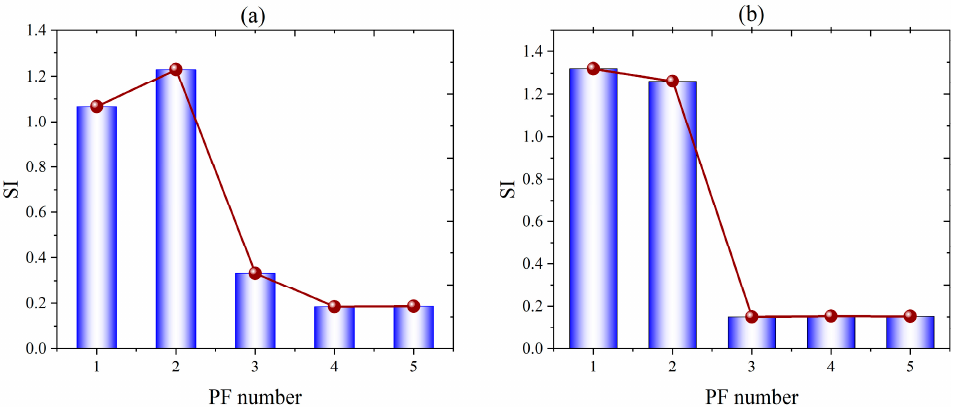
Figure 17. ( a ) The 2400 r/min compound fault signal and ( b ) its envelope spectrum.